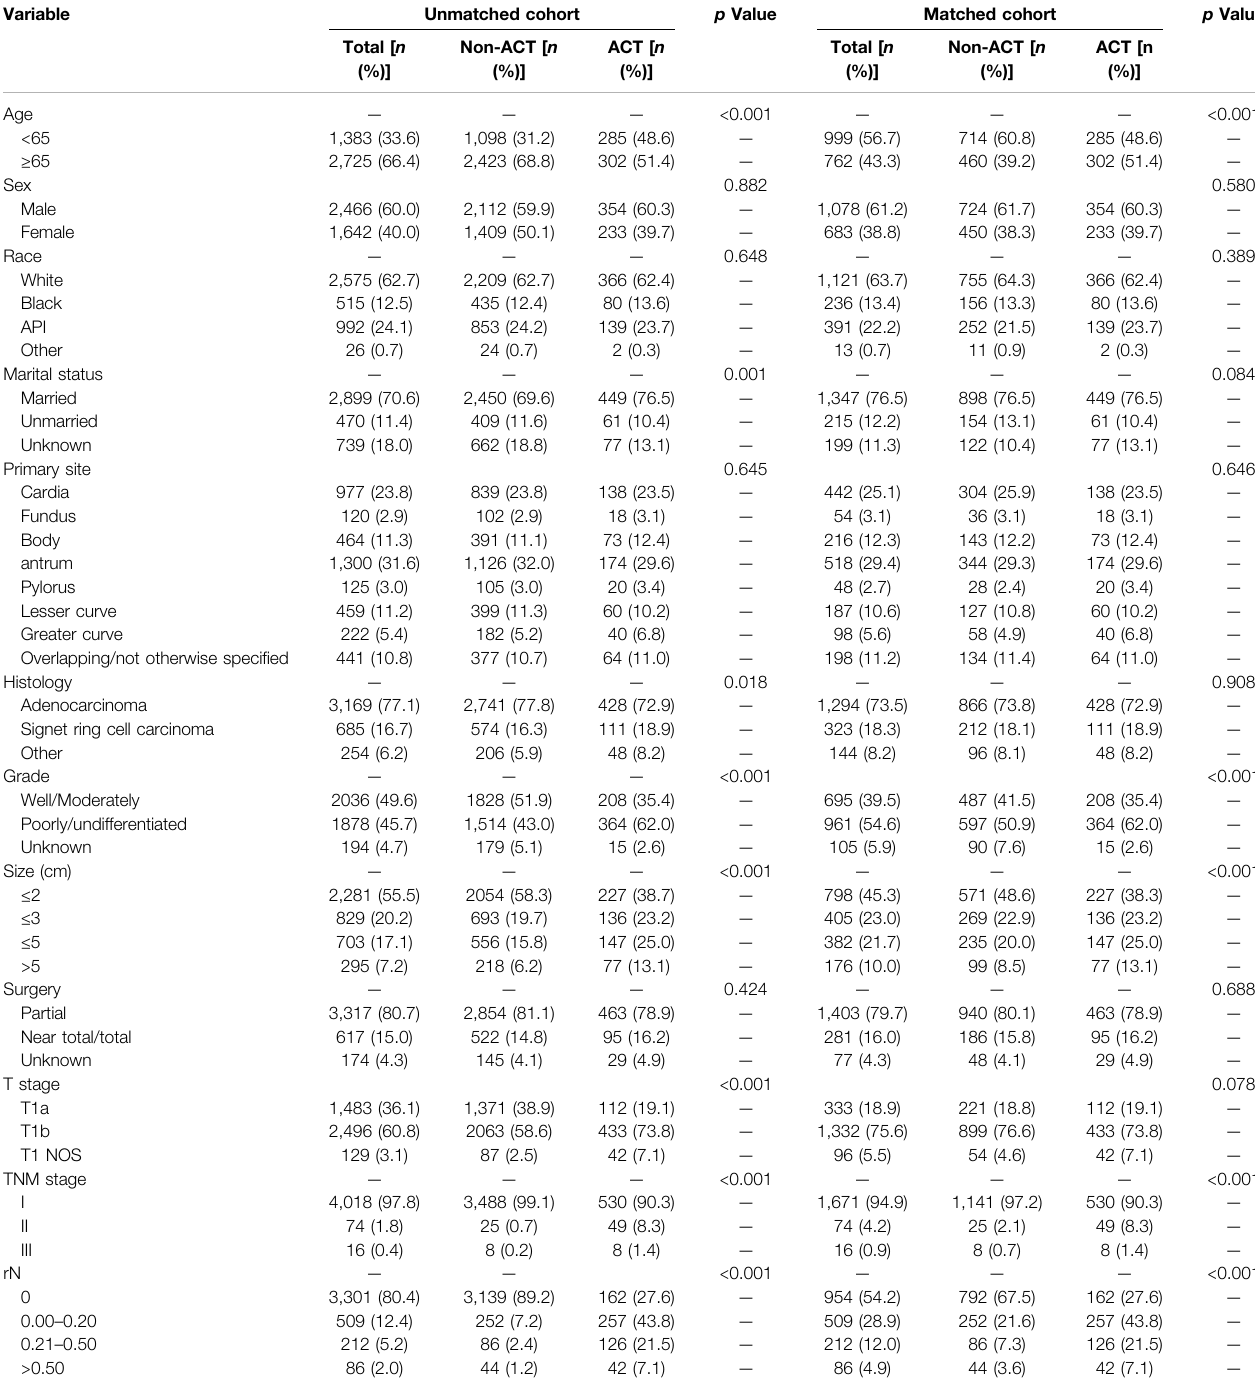
TABLE 1 | Characteristics of